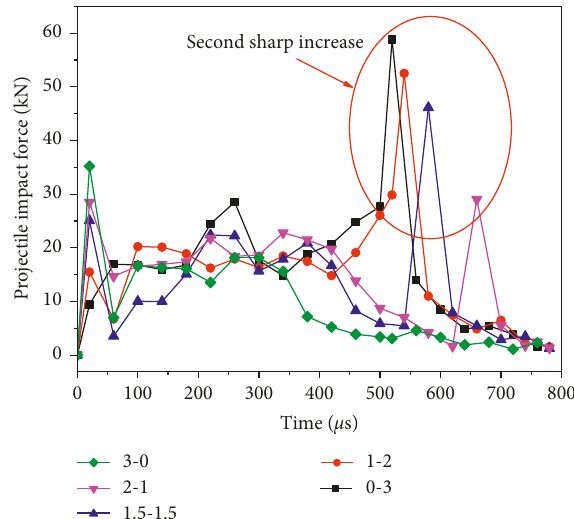
Figure 14: Impact force-time curves of a projectile with different steel liner